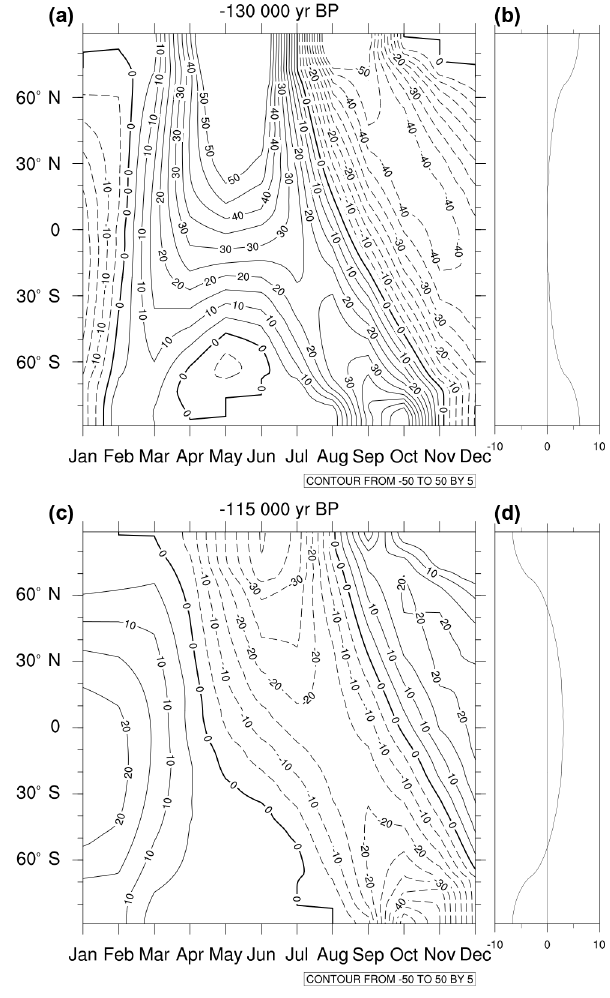
Figure 6. Zonal mean departures of (a, c) monthly and (b, d) an- nual insolation from preindustrial conditions for (a, b) 130 and (c, d) 115ka. On (a) and (c) contours are drawn every 5Wm − 2 from − 50 to 50Wm − 2 . Full lines are for positive deviations (Eemian values larger than preindustrial ones).